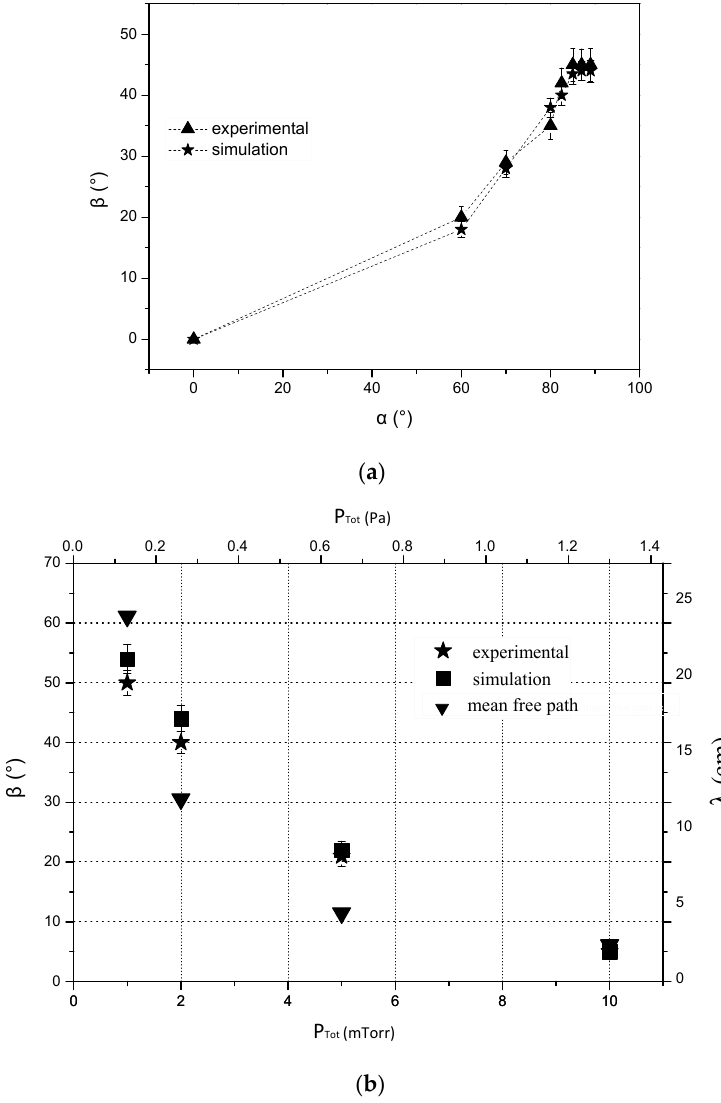
Figure 6. Evolution of the experimental and simulated values of the columnar angle β as a function of the tilt angle, α ( a ) and of the working pressure, P Tot ( b ) for Mg nano-sculpted films and the mean free path. The films were deposited for a discharge power of 50 W.